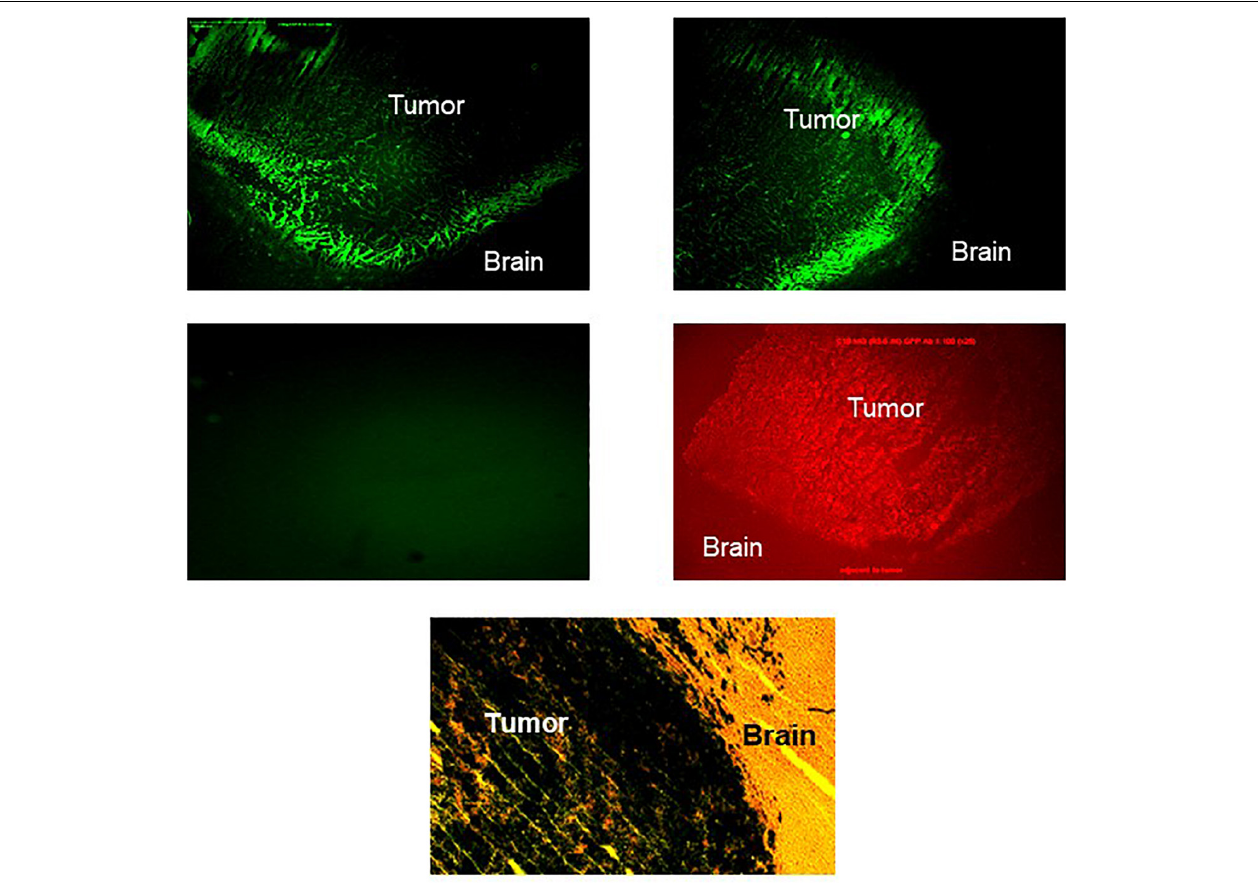
FIGURE 1 | Increased IGF-IR expression in the invasive margins of intra-cerebral rat glioma implants. Brain sections were prepared 20 days after the intra-cranial implantation of 10 4 C6 cells. The tissue was processed and immunostained as described in the section “Materials and Methods,” using anti IGF-IR ( top panel, left and right , showing two different areas of the tumor-brain margin) or anti-GFP (middle panel, right) antibodies. Control sections were incubated with goat anti rabbit IgG antibody only (middle panel, left) . The green emission background of the GFP positive glioma cells in all sections was minimized by lowering the exposure time (see middle panel, left ). A parallel section stained for β -galactosidase activity and counter stained with hematoxylin and eosin is shown on the bottom ( × 120